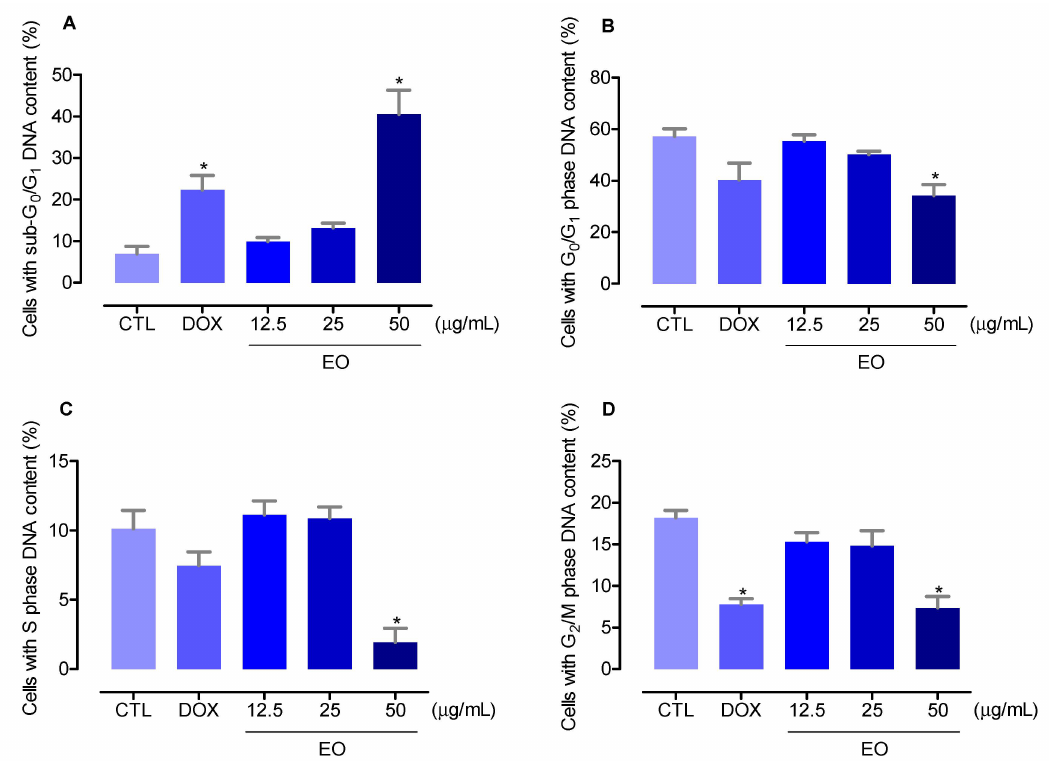
Figure 2. Effect of the essential oil (EO) from the leaves of Croton matourensis in the cell cycle distribution of HepG2 cells. ( A ) Percentage of cells with sub-G 0 /G 1 DNA content (DNA fragmentation). ( B ) Percentage of cells with G 0 /G 1 phase DNA content. ( C ) Percentage of cells with S phase DNA content. ( D ) Percentage of cells with G 2 /M phase DNA content. The negative control (CTL)